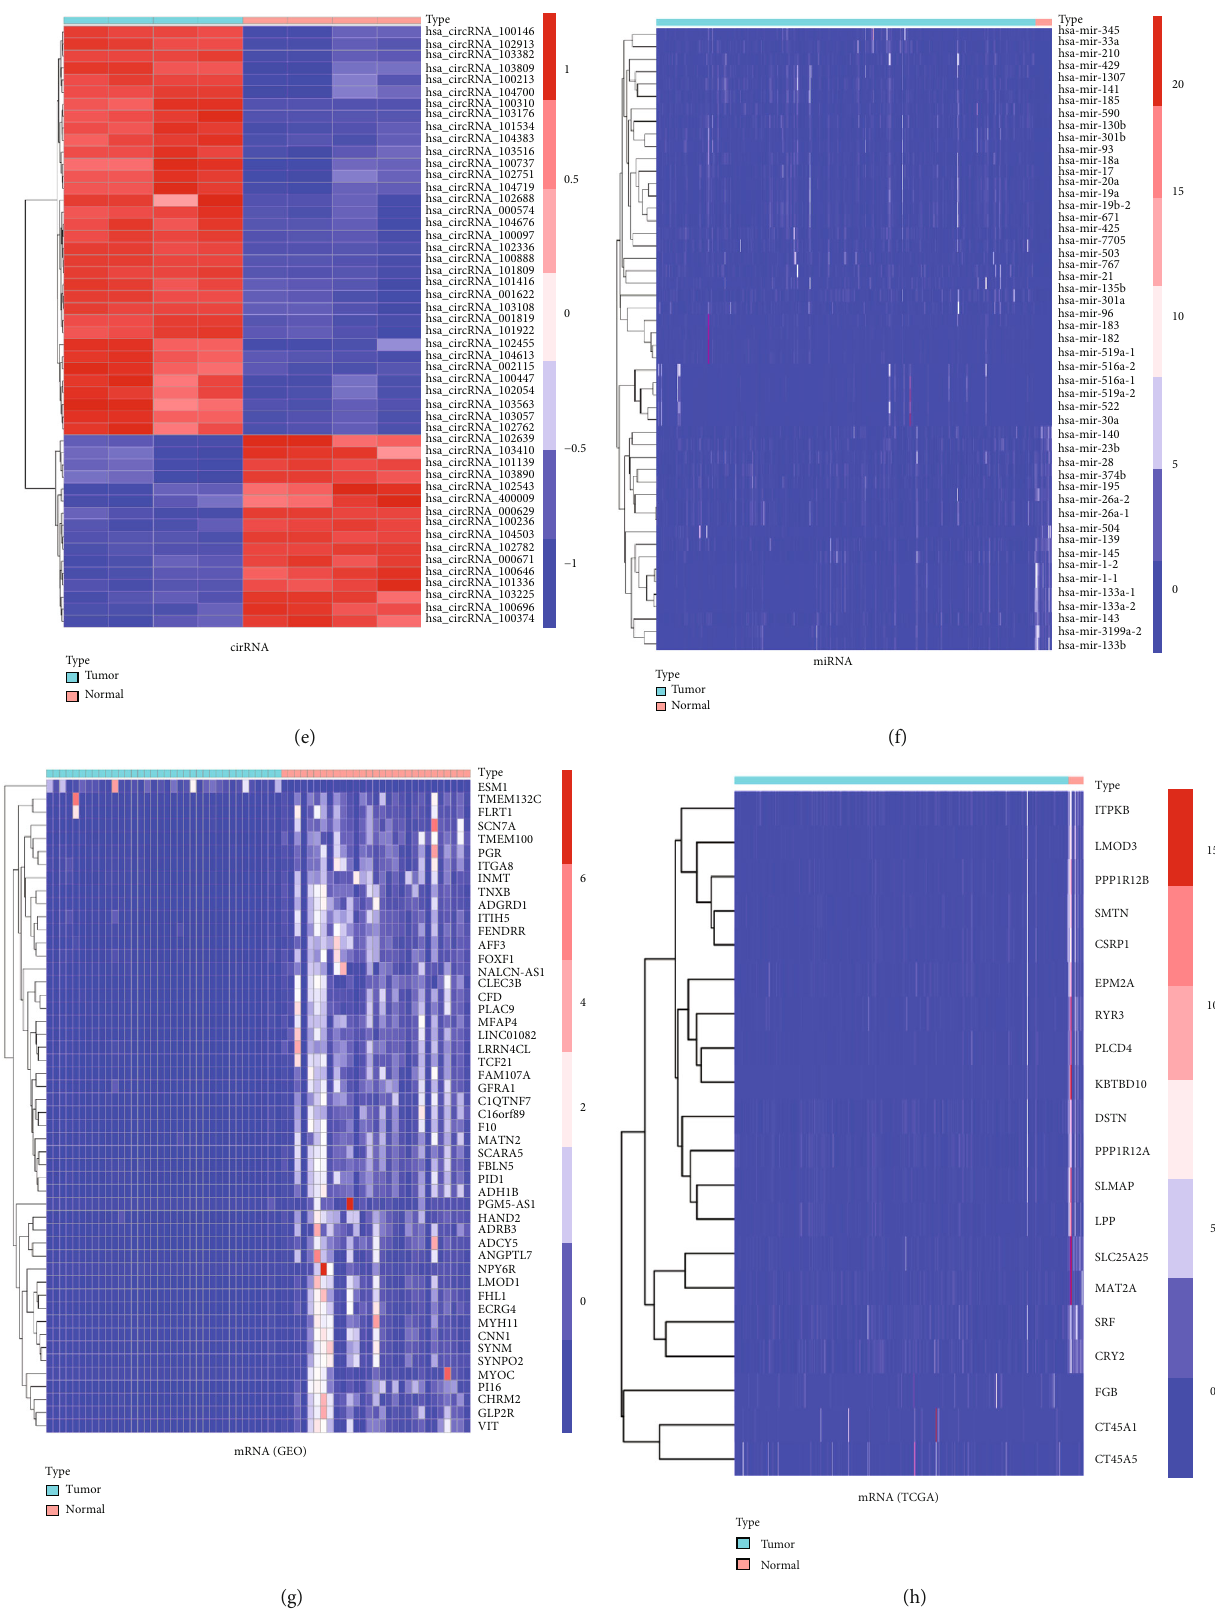
Figure 1: Volcano plots and heat maps of the di ff erentially expressed circRNAs (a, e), miRNAs (b, f), and mRNAs (c, g, d, h) datasets, respectively. The DEGs were identi fi ed with the conditions of PFDR < 0 : 05 and Ilog2FCI ≥ 1 . DEGs: di ff erentially expressed